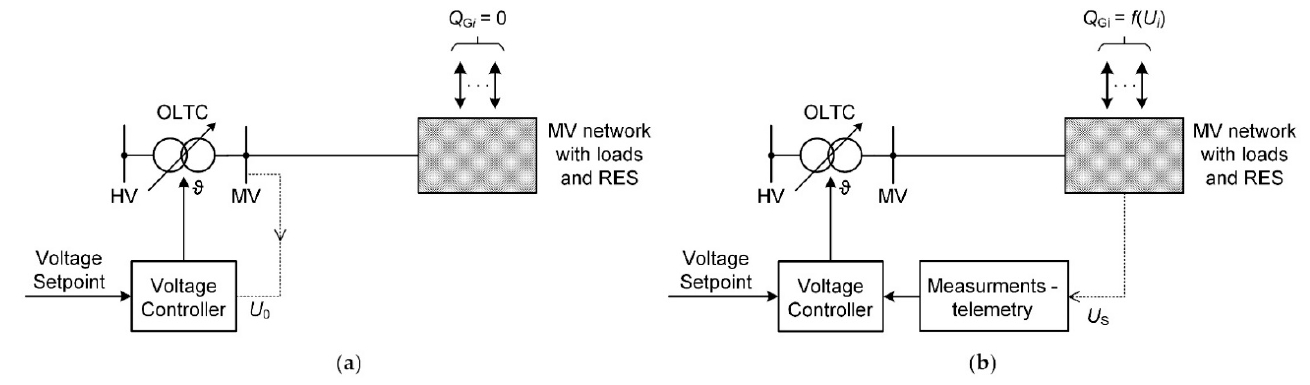
Figure 4. Simplified methods of voltage control in the MV grid with distributed generation: ( a ) tra- ditional regulation—keeping a constant voltage value on the MV busbars, ( b ) keeping a constant voltage value in an optimally selected node deep inside the grid and activating the characteristics of Q(U) inverters.